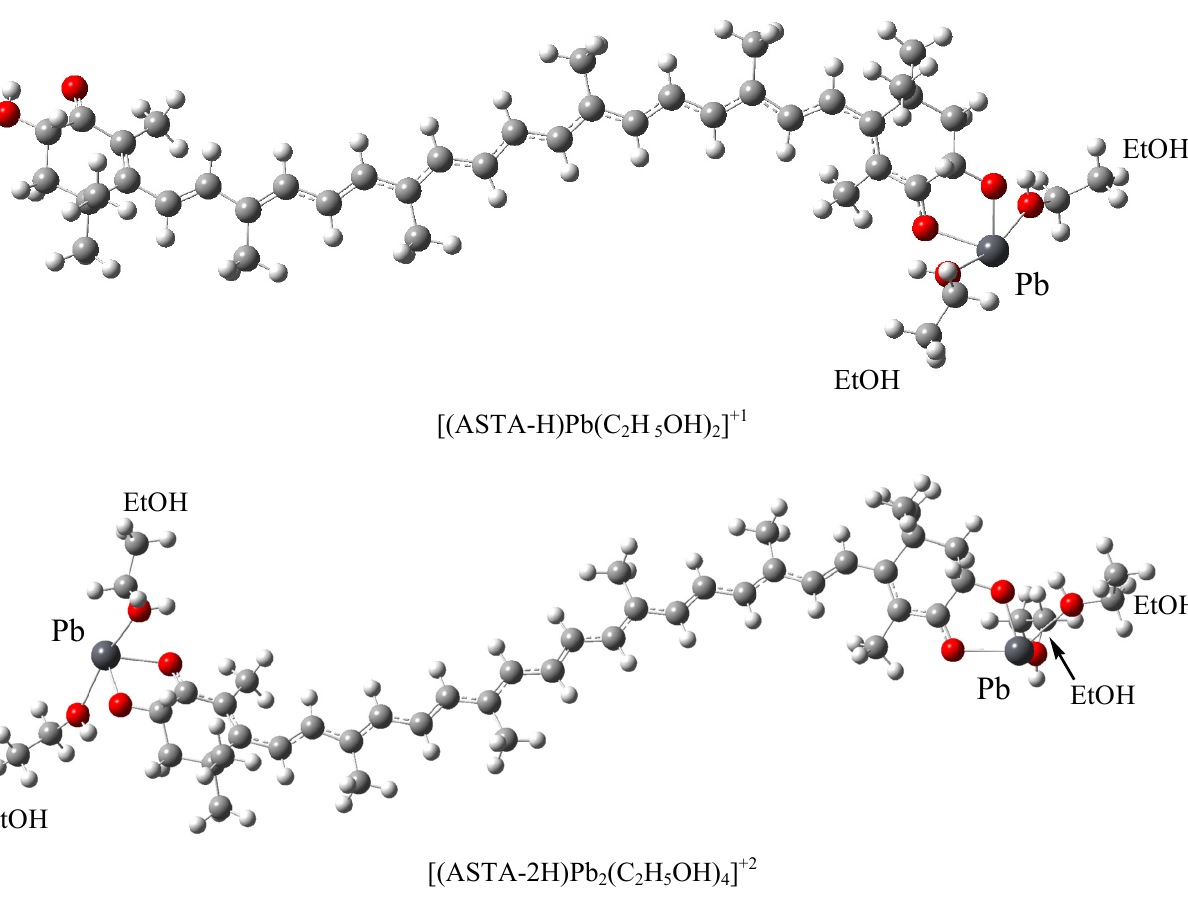
Figure 3. Optimized structures of [(ASTA-H)Pb(C